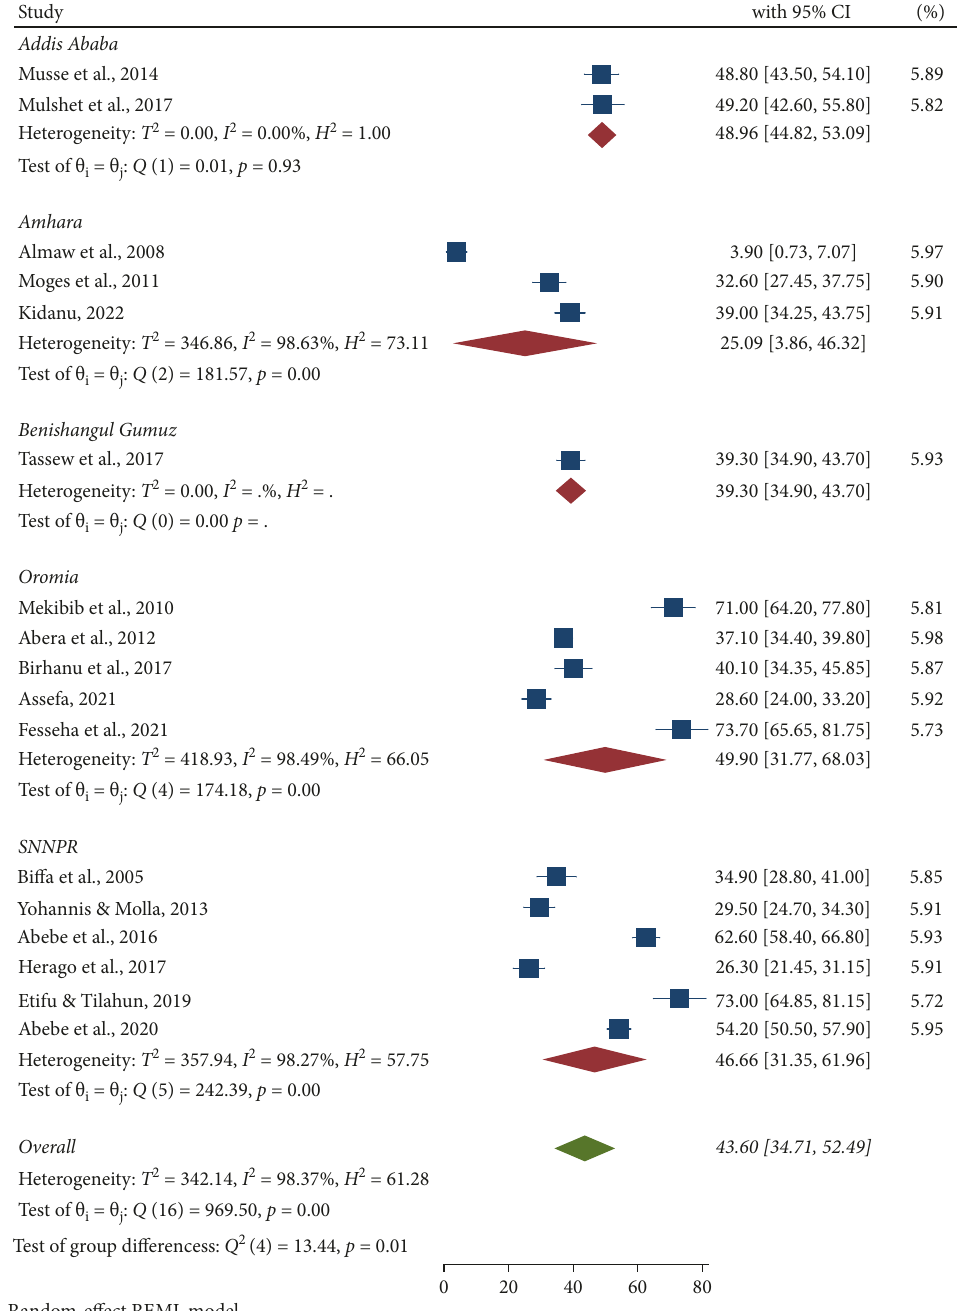
Figure 3: Pooled prevalence of bovine mastitis among dairy cows by